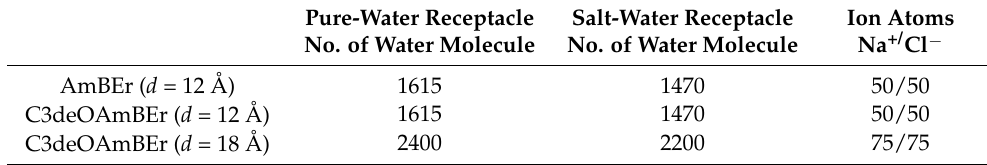
Figure 2. Forward osmosis filtration simulation model. Table 1. Details of the forward osmosis simulation